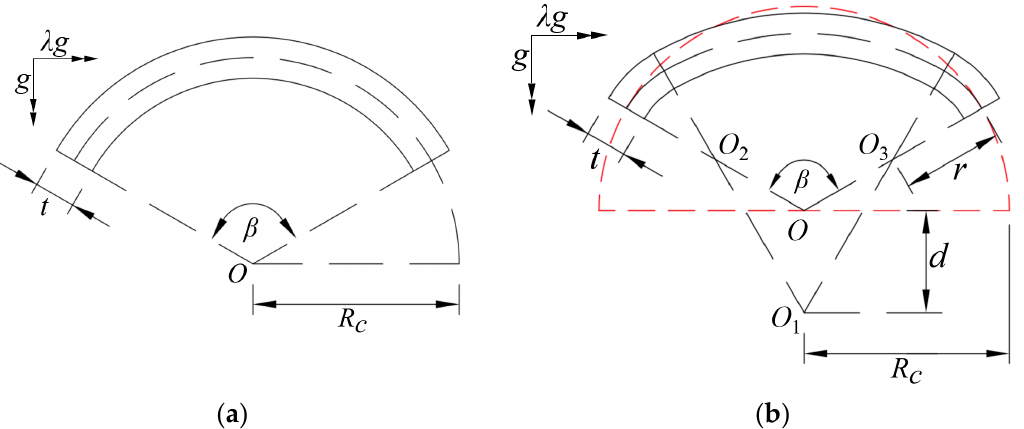
Figure 3. Geometry of arches: ( a ) circular arch; ( b ) basket-handle arch.